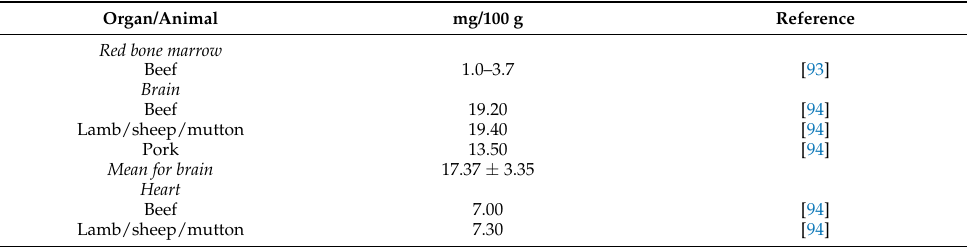
Table 2. Ascorbic acid contents of farmed food